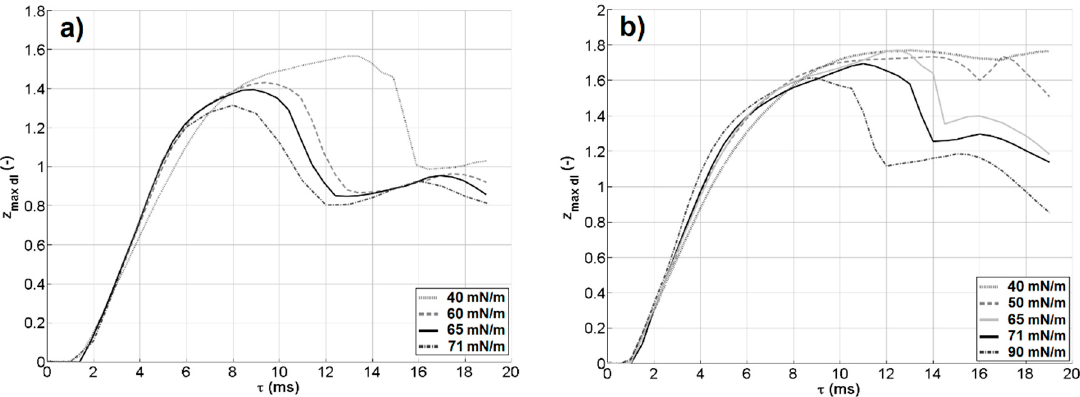
Figure 9. Time evolution of z max dl as a function of the water surface tension for case A (w = 1.0 m/s, ( a) ) and for case B (w = 1.4 m/s, ( b) ).